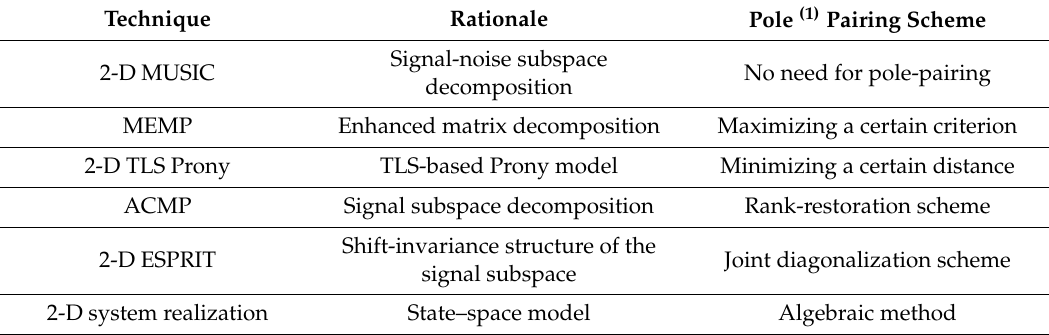
Table 1. Synopsis of the 2-D subspace-based